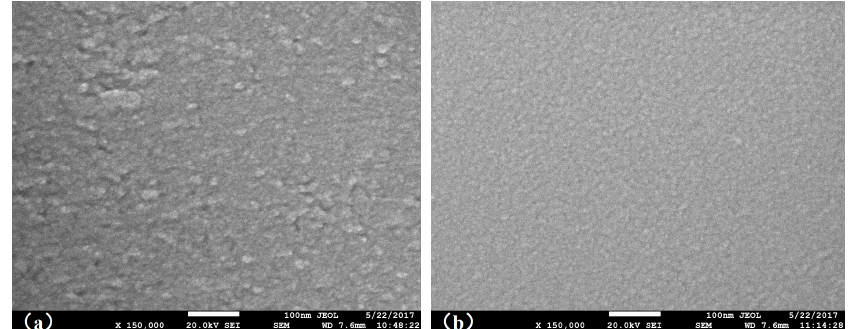
Figure 4. Contrast SEM image of GaAs surface ( a ) unpassivated ( b ) ODT passivated. The scale bar of both SEM images is 100 nm.